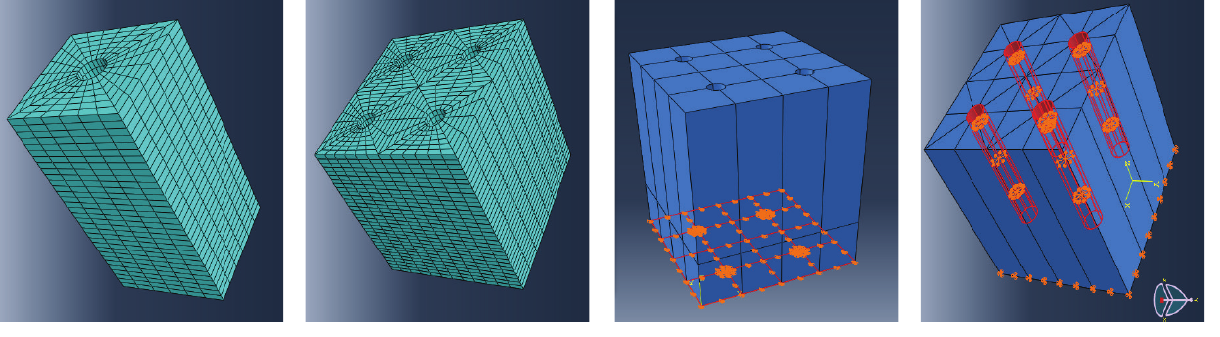
Figure 9: Finite element models.